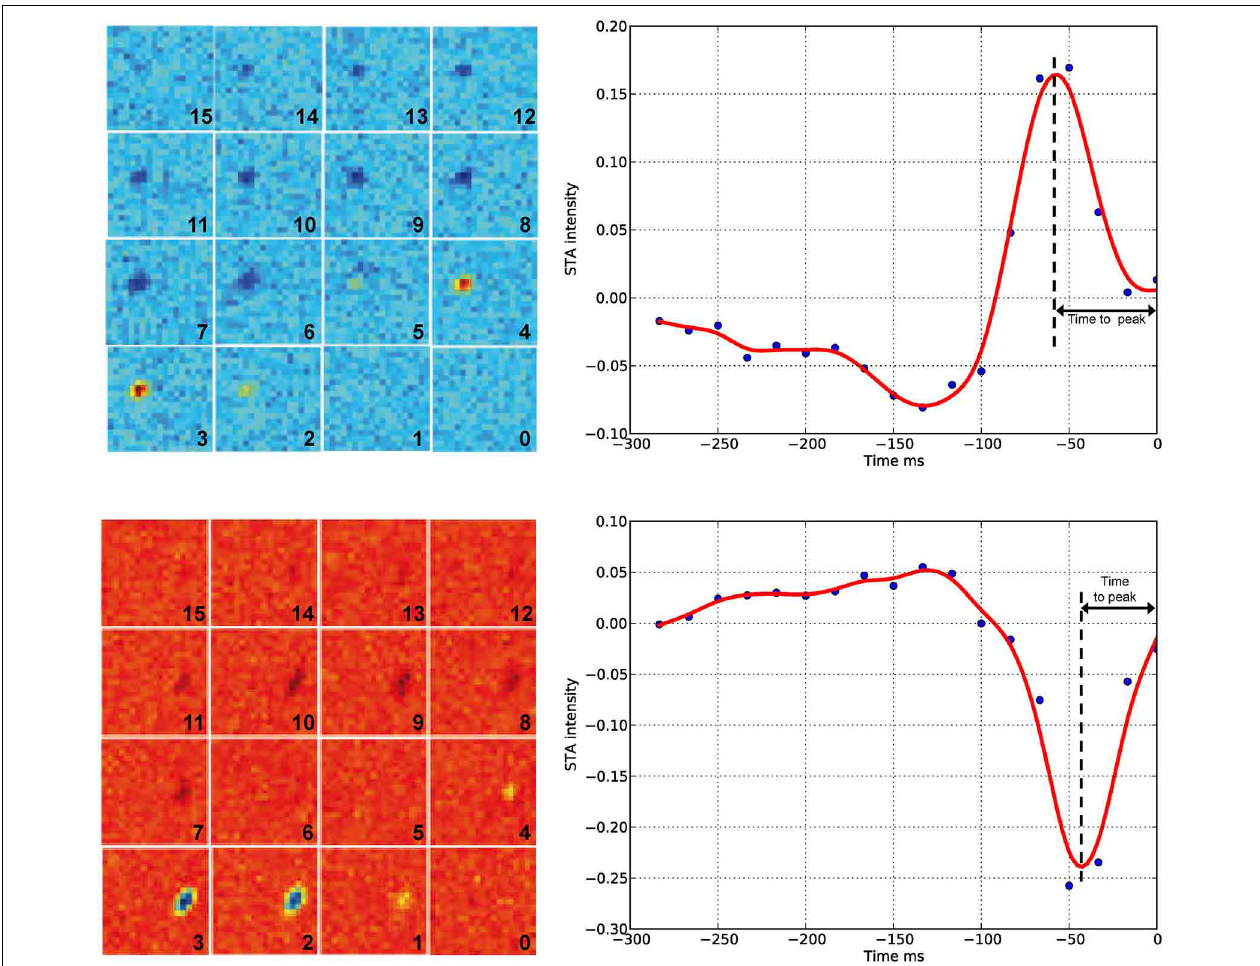
FIGURE 4 | Spike-triggered average (left) and temporal profile (right) under control conditions. The left panel shows the result of the STA algorithm on the response of GCs to checkerboard stimuli. Each frame has a number indicating the order before the spike time (zero represents the spike occurrence time point). The complete sequence covers − 250ms before the spike time with a time resolution of 16.67ms. Blue/red represents low/high intensities, respectively. Top, example of an ON GC (STA estimated from n = 2882 spikes); bottom, example of an OFF GC (STA estimated from